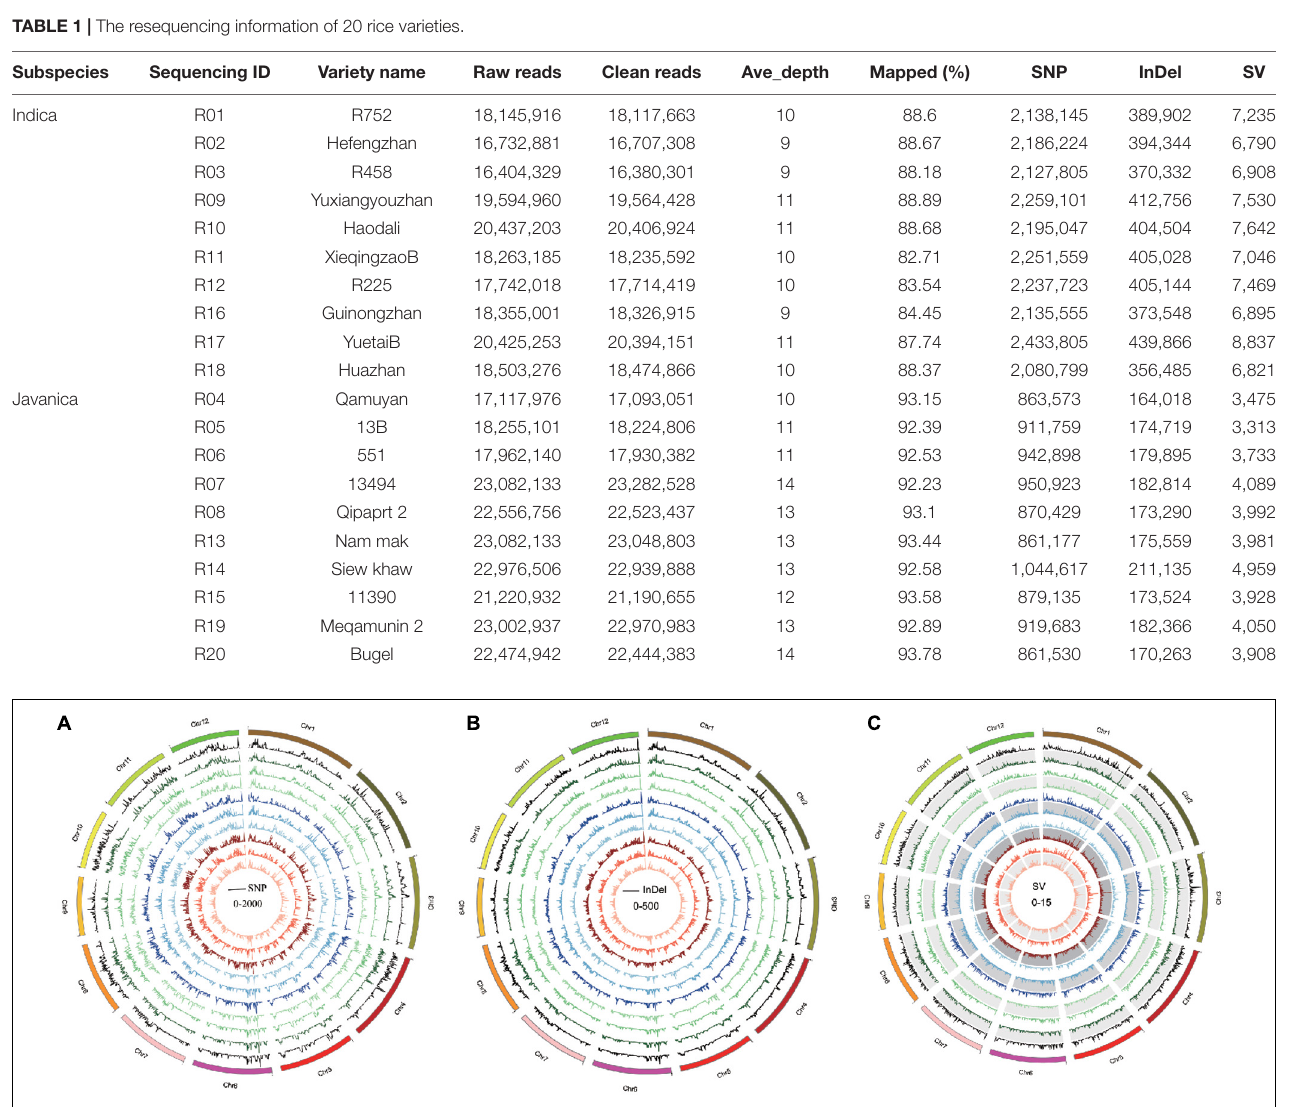
FIGURE 2 | Genome-wide variation pattern of the 10 Oryza javanica. (A) The SNP variation distribution of 10 Oryza javanica among the genome. (B) The InDel variation of 10 Oryza javanica. (C) . The SV pattern of 10 Oryza javanica was characterized with Nipponbare reference